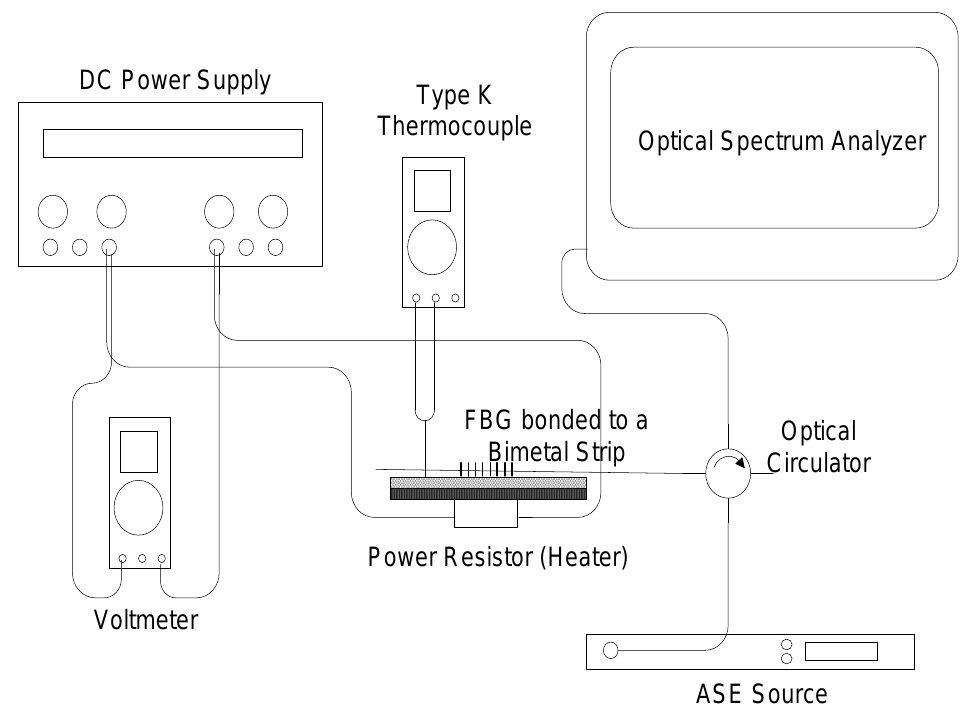
Figure 2. Experimental setup for the sensor